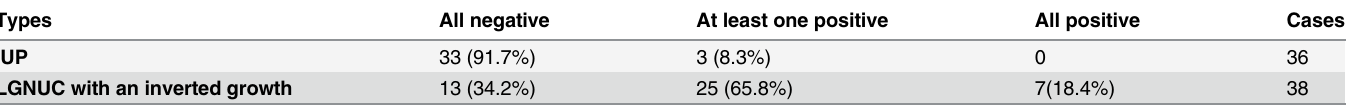
Table 3. The distribution of Ki-67 and CK20 in IUP and LGNUC with an inverted growth pattern.